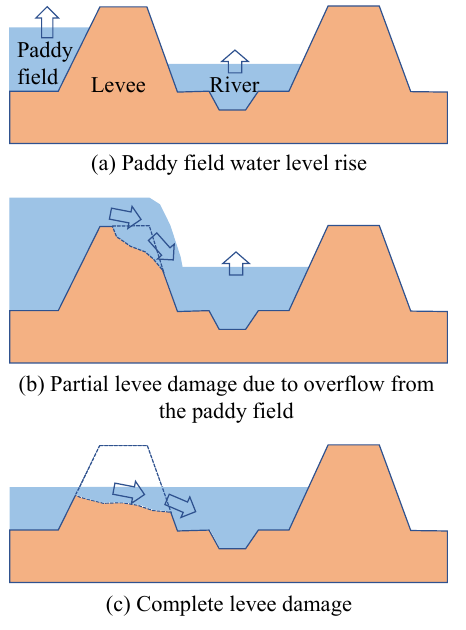
Figure 19. Breaching mechanism of the downstream levee locations: ( a ) Paddy field water level rise, ( b ) Partial Levee damage due to overflow from the paddy field, ( c ) Complete levee